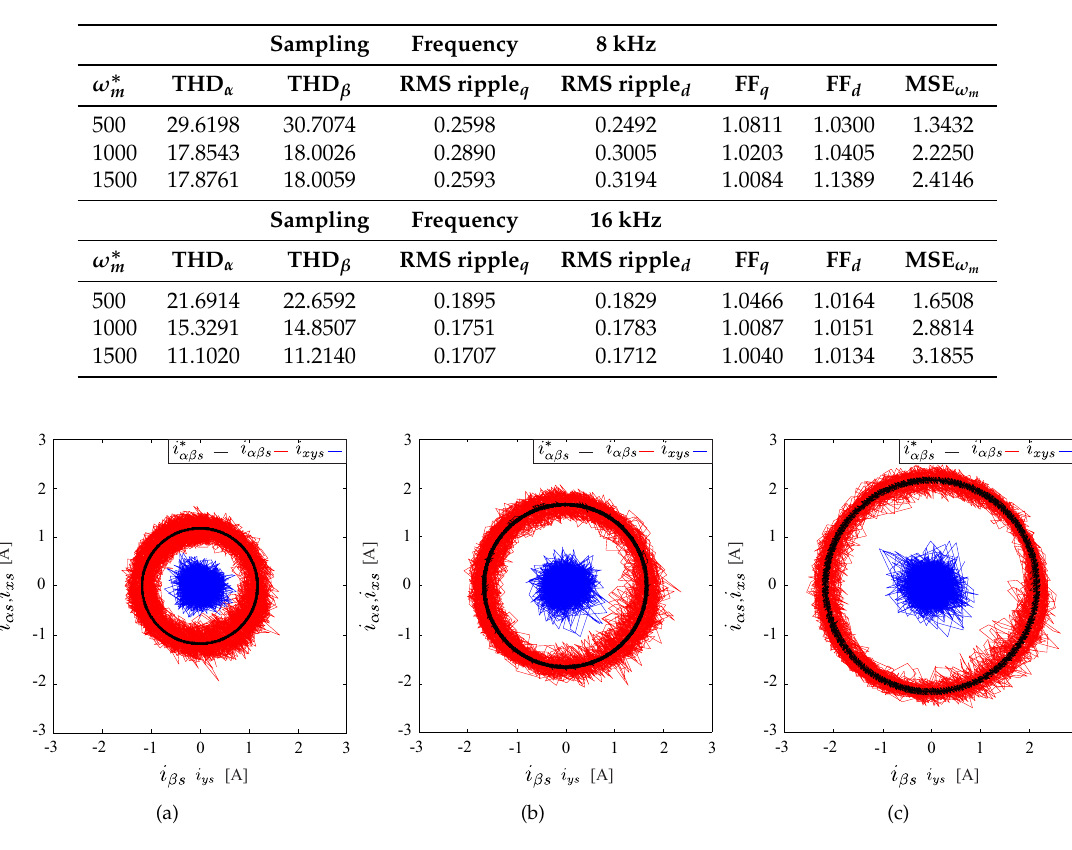
Figure 4. Stator currents in the α − β and x − y planes for a rotor speed ω m of: ( a ) 500 rpm; ( b ) 1000 rpm; ( c ) 1 500 rpm.